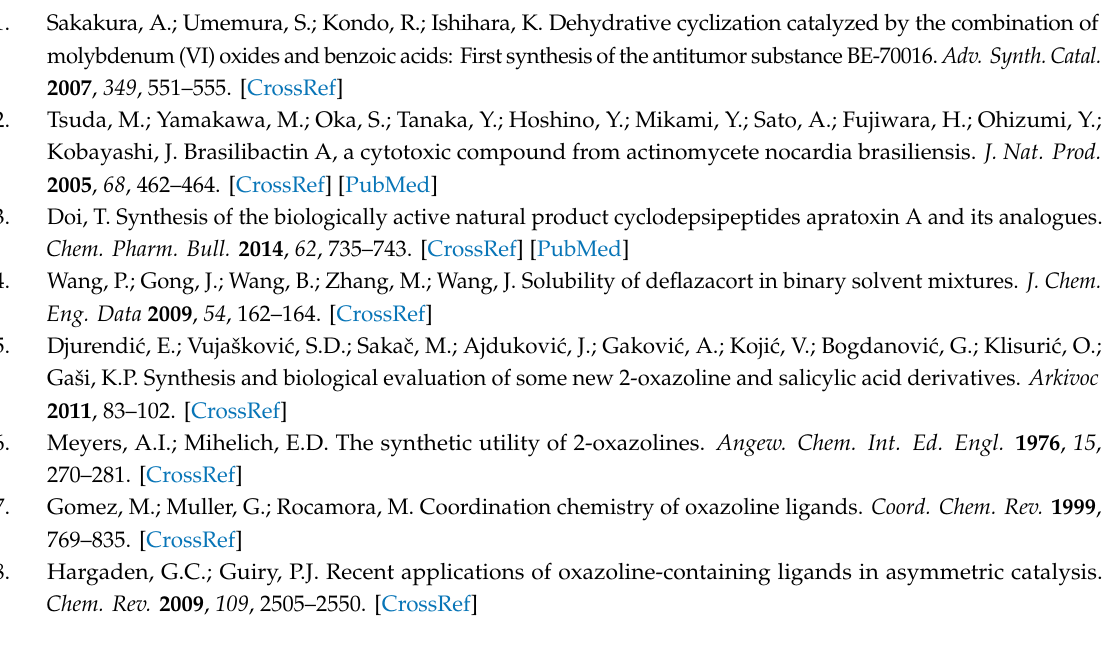
2 , Figure S2: 1 H-NMR spectrum (in acetone- d 6 ) of compound 2 , Figure S3: 1 H-NMR spectrum (in CD 3 OD) of compound 2 , Figure S4: Heteronuclear 1 H- 13 C spectrum of compound 2 and crystallographic data for compound